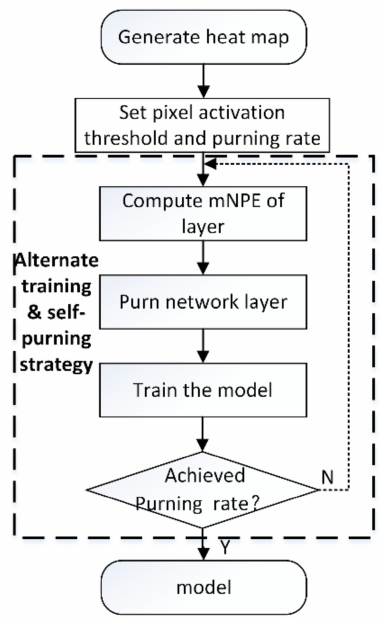
Figure 5. Alternating training and self-pruning